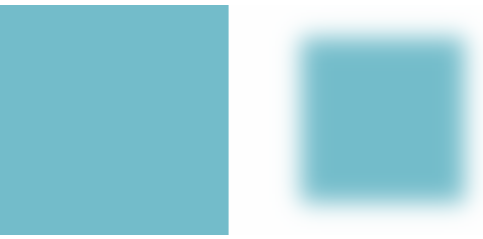
Figure 9. Graphical representation of a conventional set and a fuzzy set.